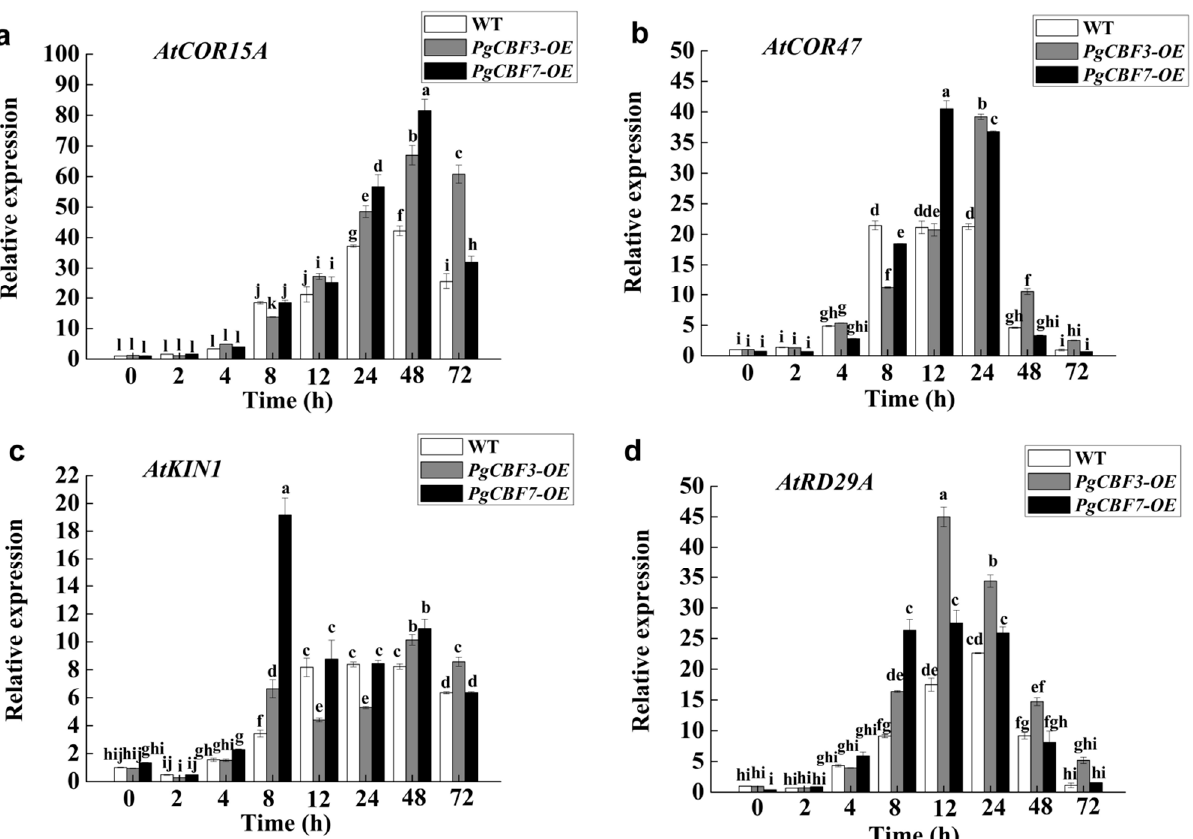
Figure 8. Relative expressions levels of the four cold-responsive genes AtCOR15A ( a ), AtCOR47 ( b ), AtKIN1 ( c ), and AtRD29A ( d ) in PgCBF3 and PgCBF7 transgenic Arabidopsis under cold stress. Different letters present significant differences ( p < 0.05).